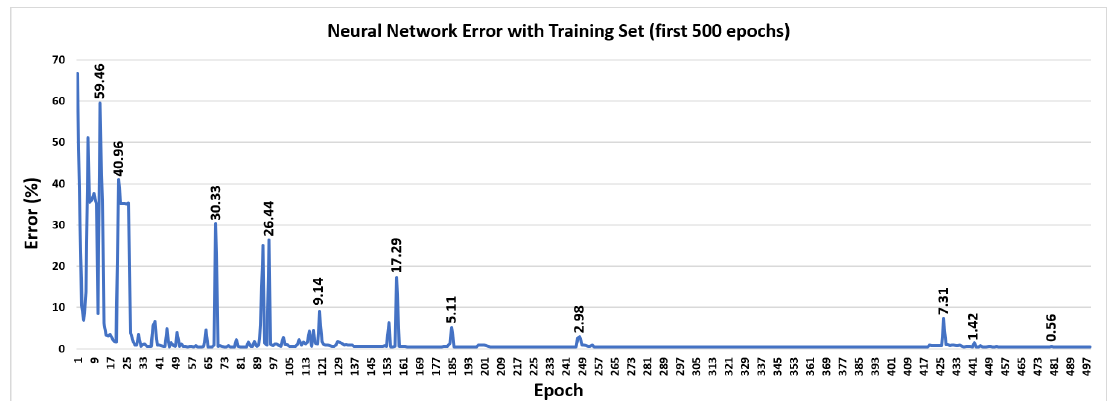
Figure 10. Error obtained during the training process after each epoch (epochs 1 to 500 represented) using the training dataset itself.